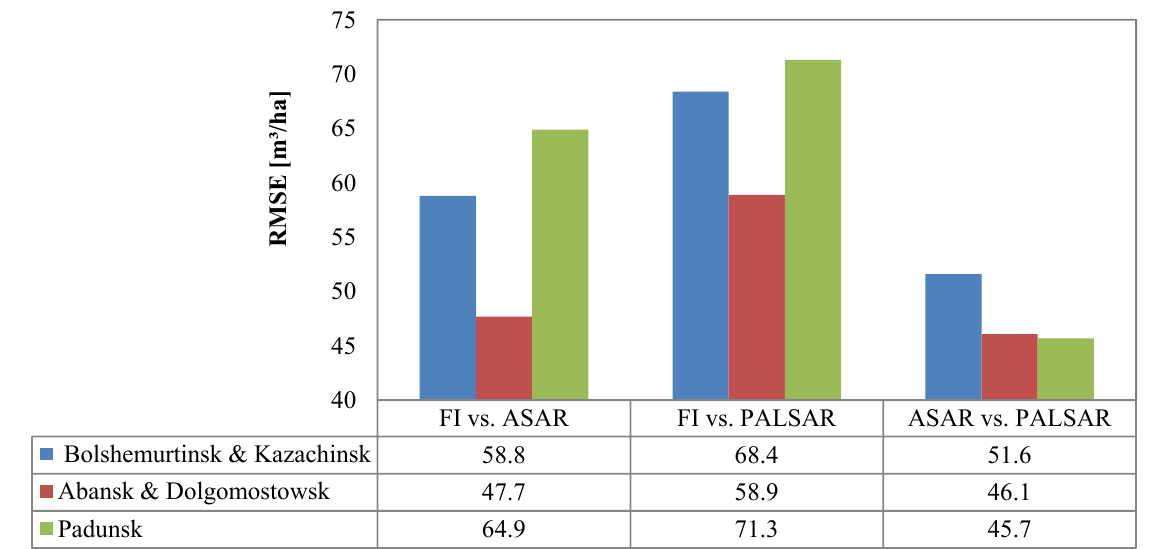
Figure 8. Cross-comparisons of the GSV retrievals from forest inventory, ASAR-based mapping and PALSAR- based